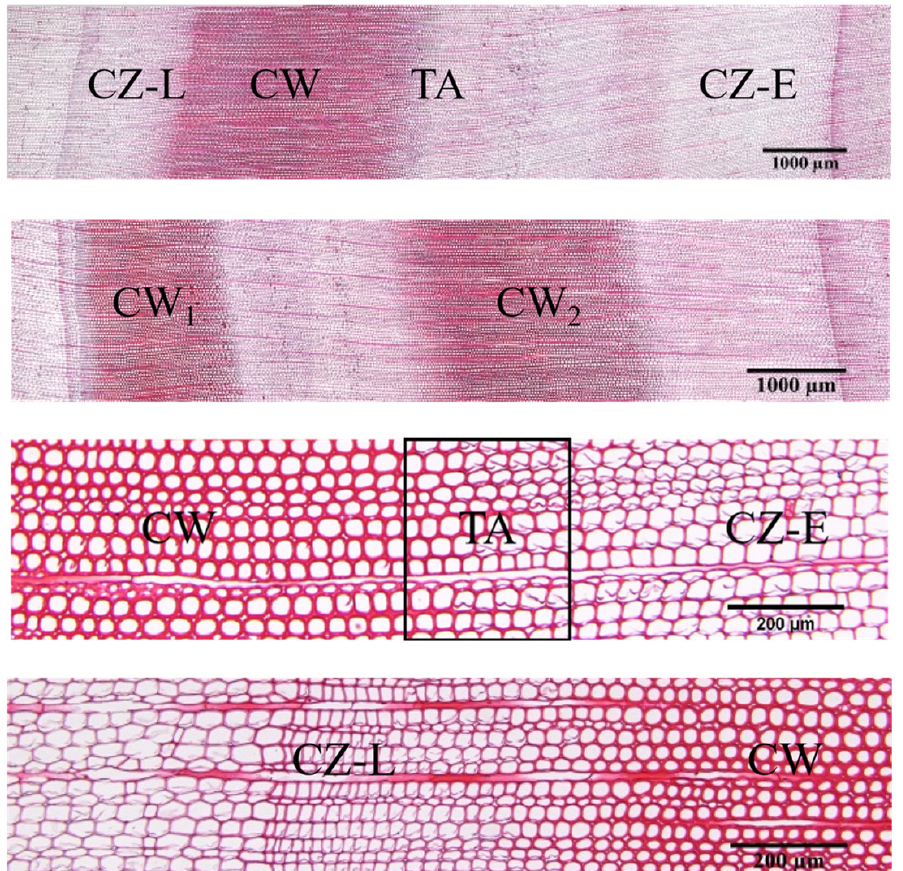
Figure 3. The position of CW within the growth ring of T . Zhongshanshan. (CZ-E: early wood of CZ; CZ-L: late wood of CZ).